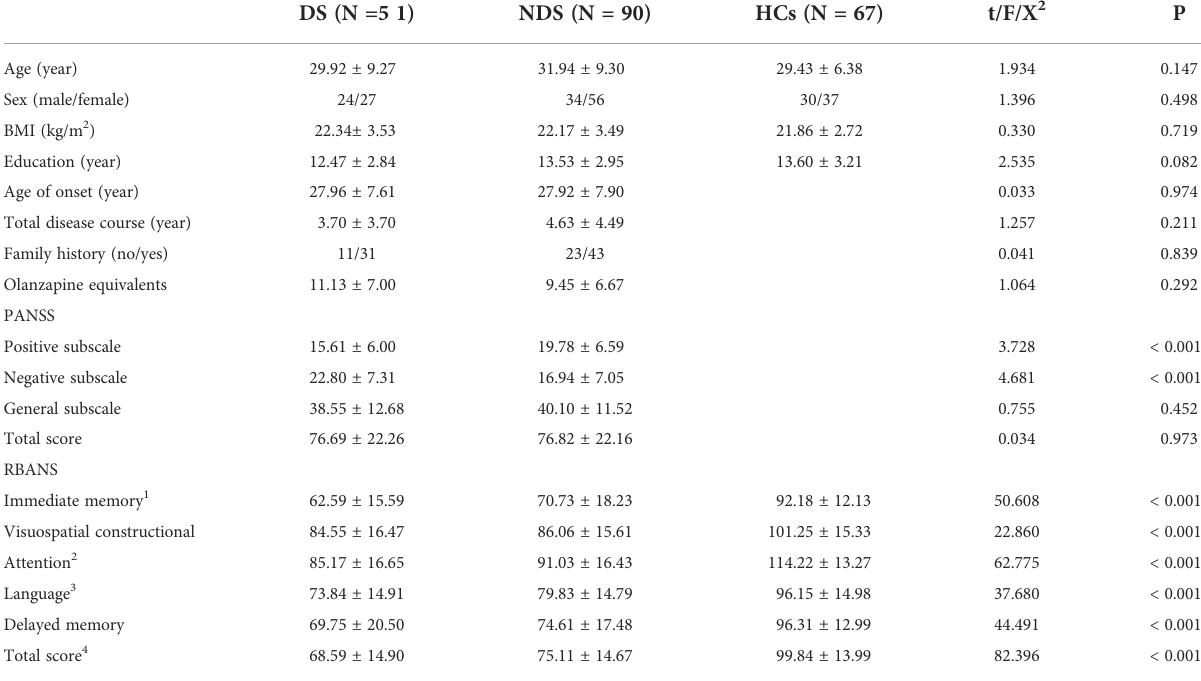
TABLE 1 Demographics, and cognitive function in de fi cit and nonde fi cit